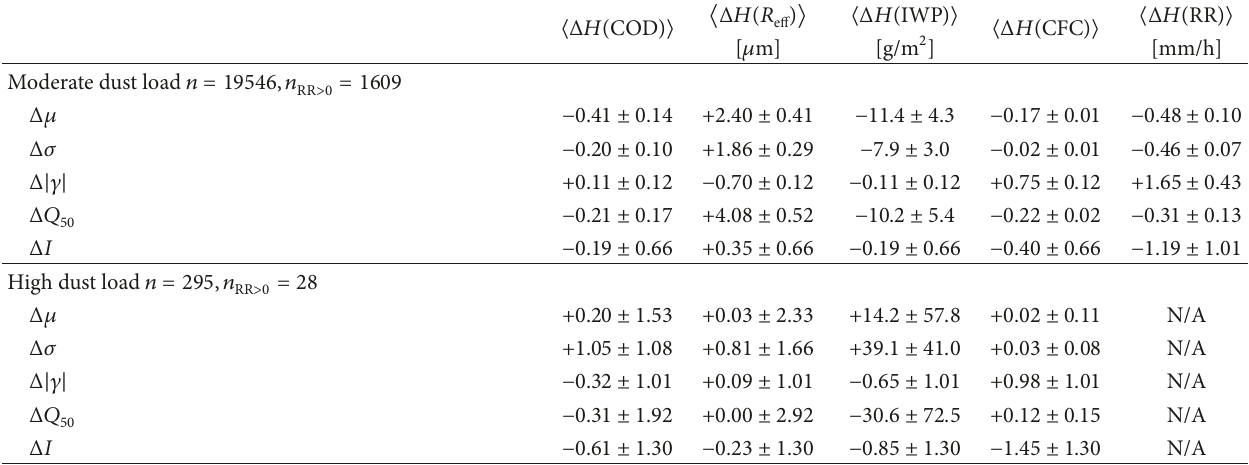
Table 3: Mean value of distributions of differences Δ H for four cloud variables COD, 𝑅 dust loading subsets limited to the subset of deep ice clouds only. Here, CTT has been used to describe the meteorological state.